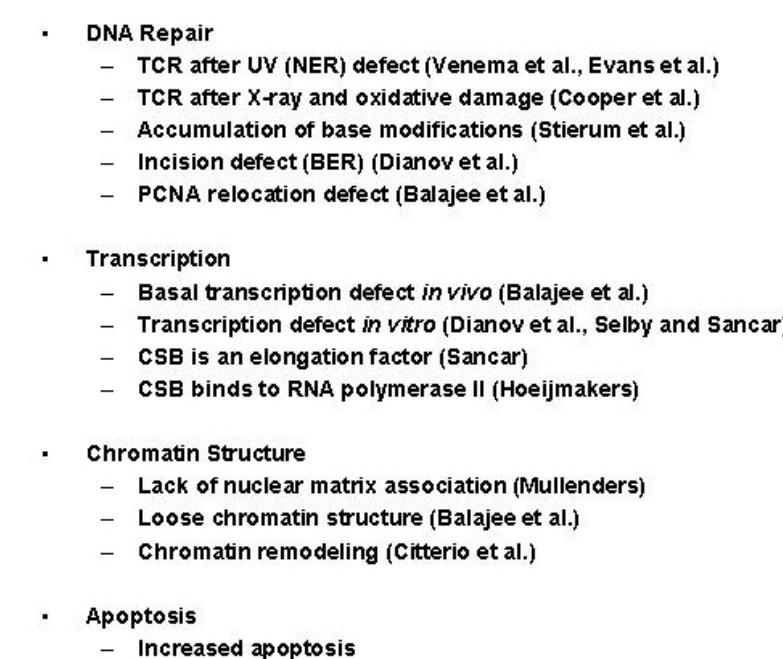
DNA Repair Transcription, and Chromatin Structure in Cockayne Syndrome